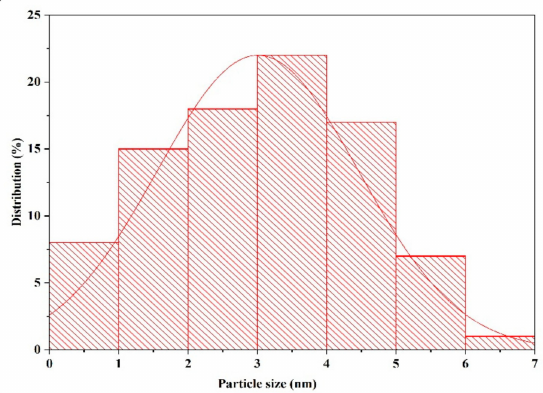
Figure 4. Noble metal nanoparticle size distribution of sample P25_is-25Au/75Pt, counting 100 nanoparti- cles. The distribution was nearly the same for all the